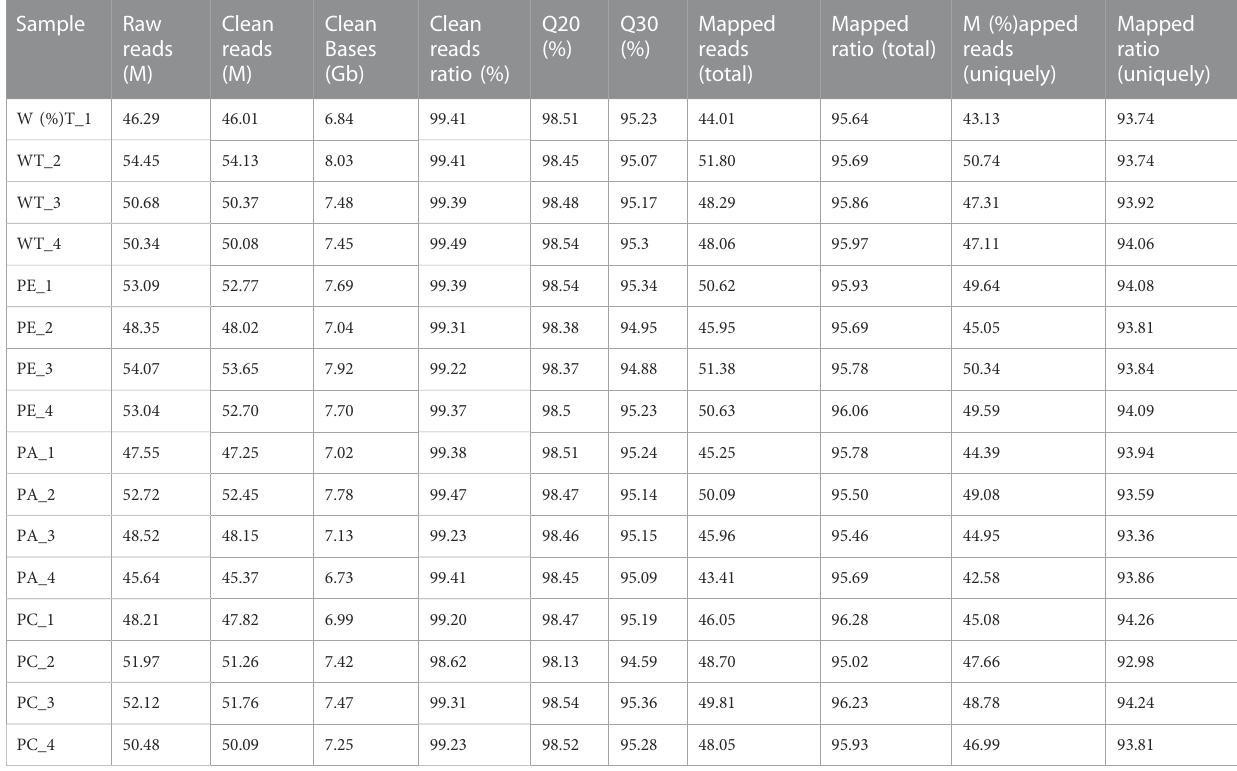
TABLE 1 Statistics of the constructed Solanum lycopersicum transcriptome database.